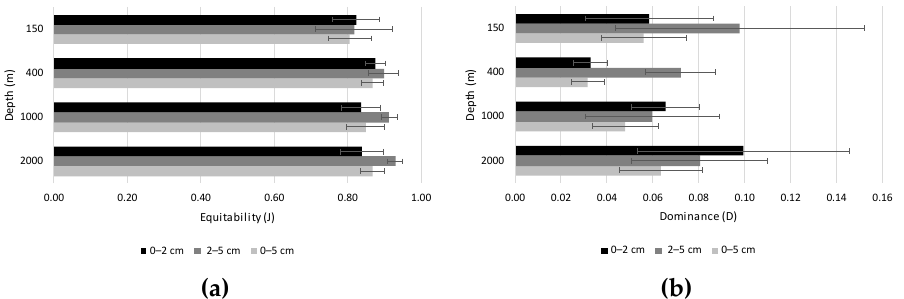
Figure 7. The mean and standard deviation of foraminifera equitability ( a ) and dominance ( b ) along the isobaths at the studied layers.